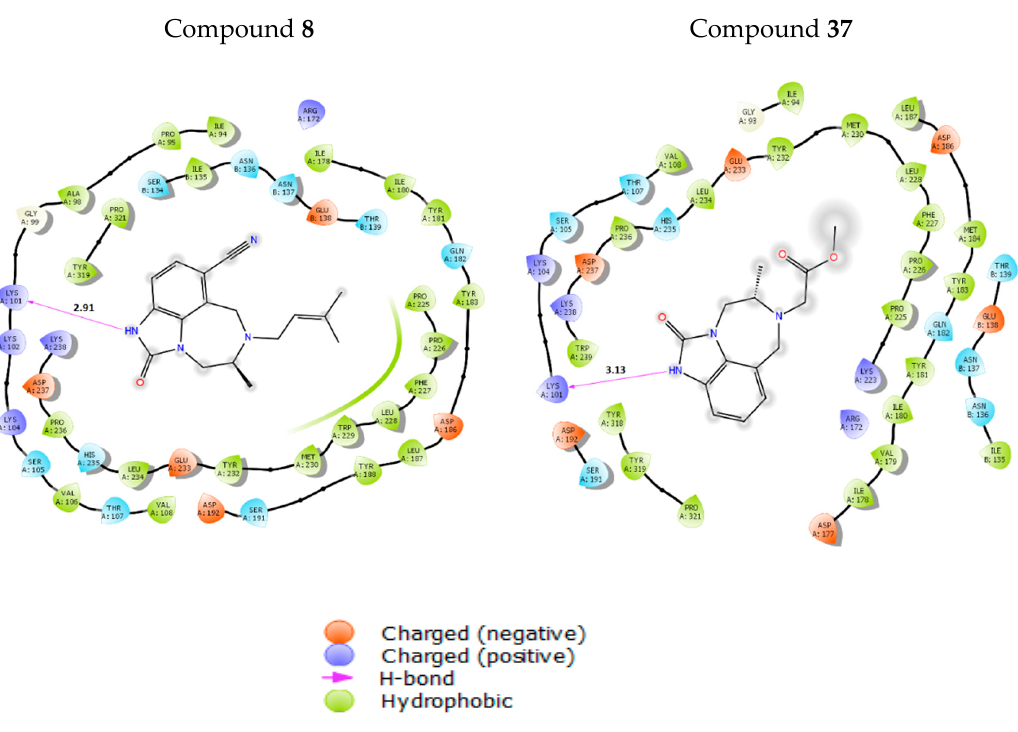
Figure 6. Hydrogen bond, hydrophobic, and electrostatic interactions as exhibited by compounds 8 ( left ) and 37 ( right ).